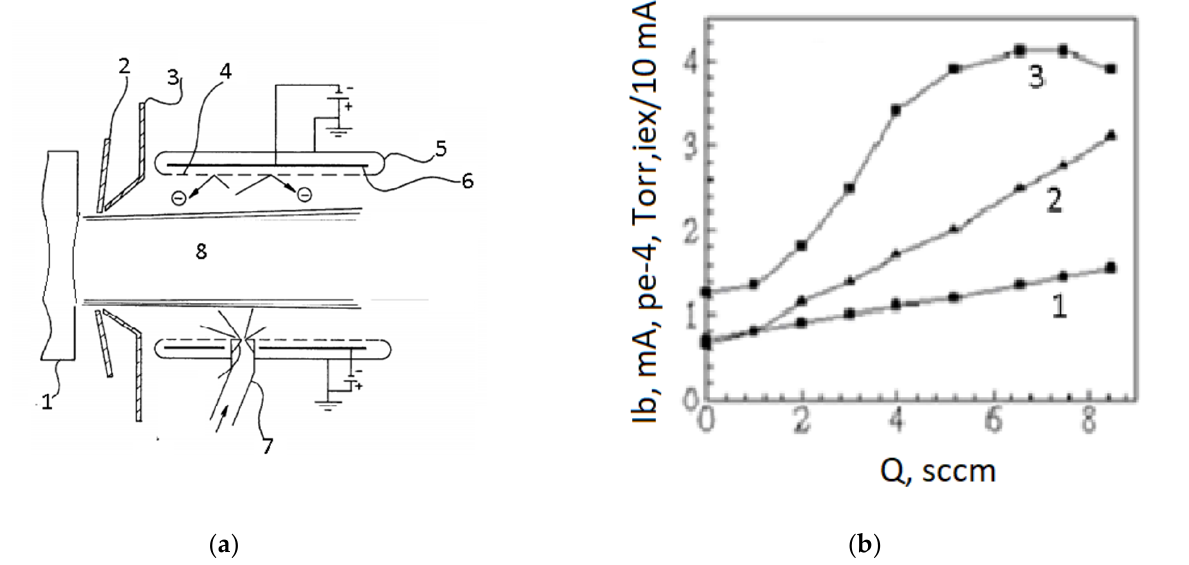
Figure 5. ( a ) Embodiment of a gas injection tunnel, which increases the density of electronegative gas near the beam and reflects electrons and negative ions into the beam. 1—ion source, 2—suppressor electrode, 3—grounded electrode, 4—inner mesh, 5—outer screen, 6—reflecting electrode, 7—gas delivery system, 8—ion beam. ( b ) Dependencies of (1) pressure of injected CF 3 gas flow, (2) extracted ion current, and (3) analyzed ion beam current, on electronegative gas flow Q.